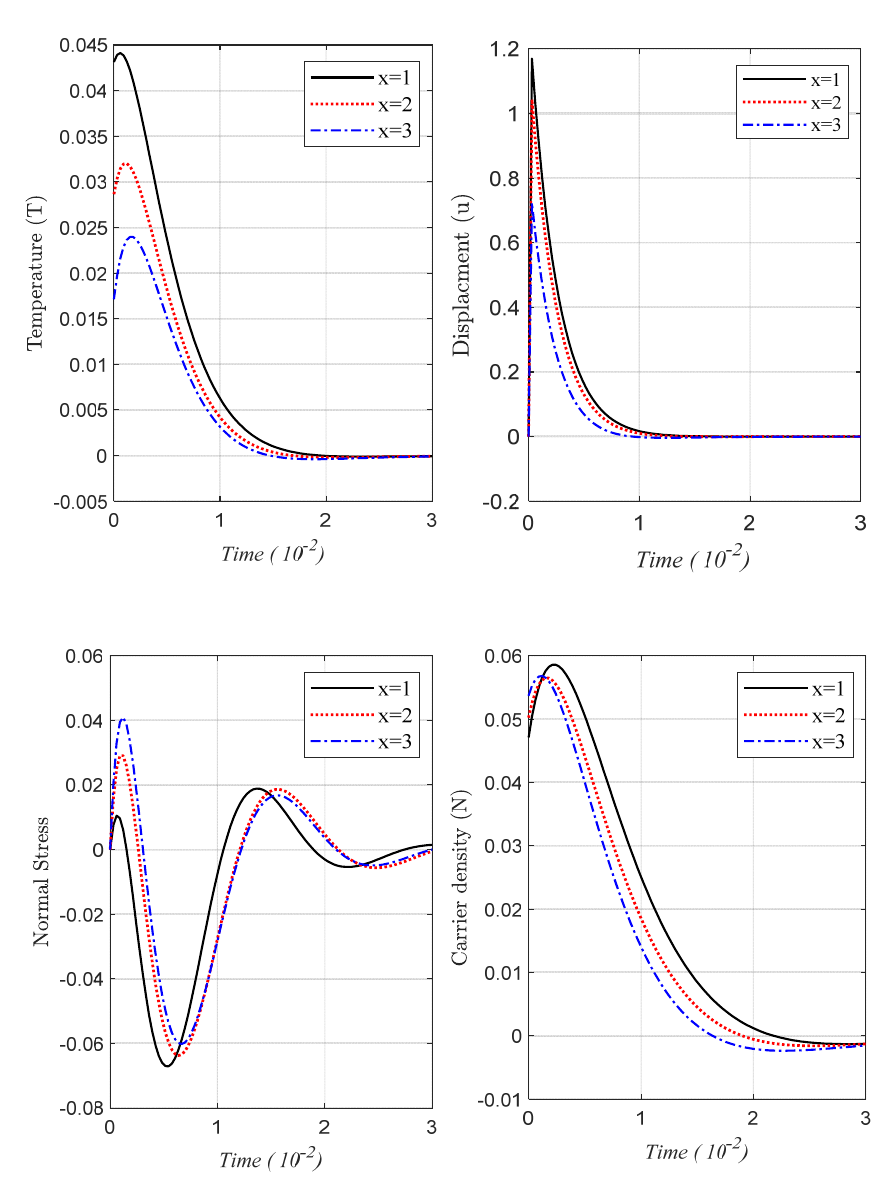
Figure 6. The wave propagation of the physical field distributions against the time interval [0, 0.03] according to Si materials in the context of the DPL model.